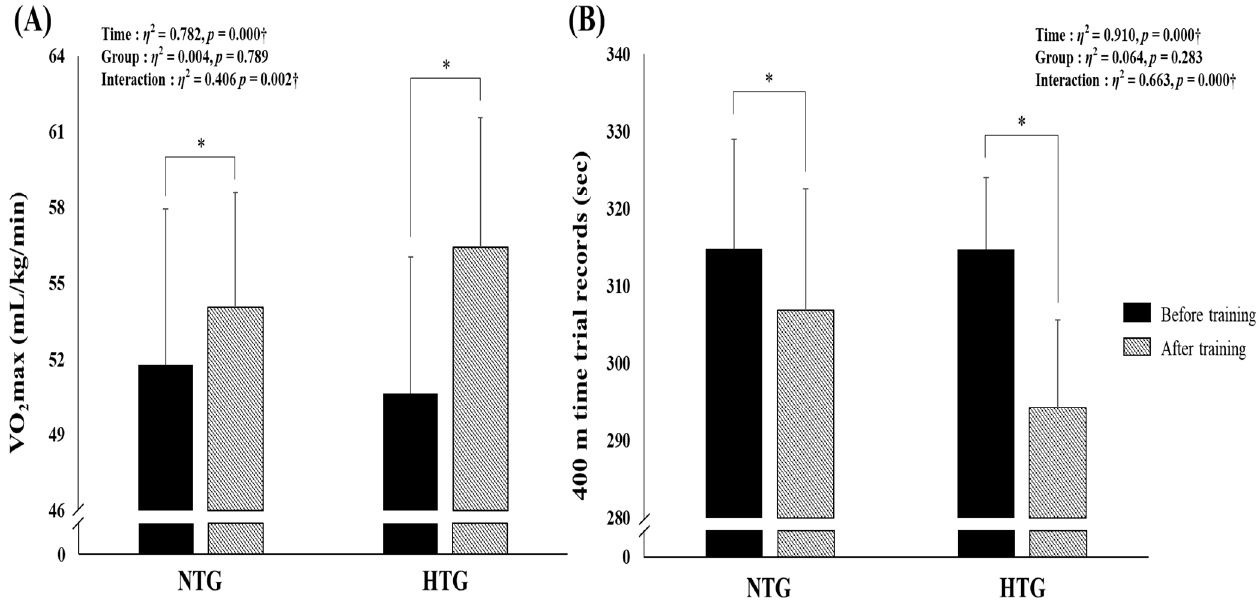
Figure 2. Changes in endurance exercise performance parameters before versus after training by group. ( A ) Change in VO 2max before versus after exercise training in each environmental condition. ( B ) Change in the 400-m time trial records before versus after exercise training in each environmental condition. HTG, hypoxic training group; NTG, normoxic training group; VO 2max , maximum oxygen uptake. Significant interaction or main effect: † p < 0.05; Significant difference before versus after training: * p < 0.05.